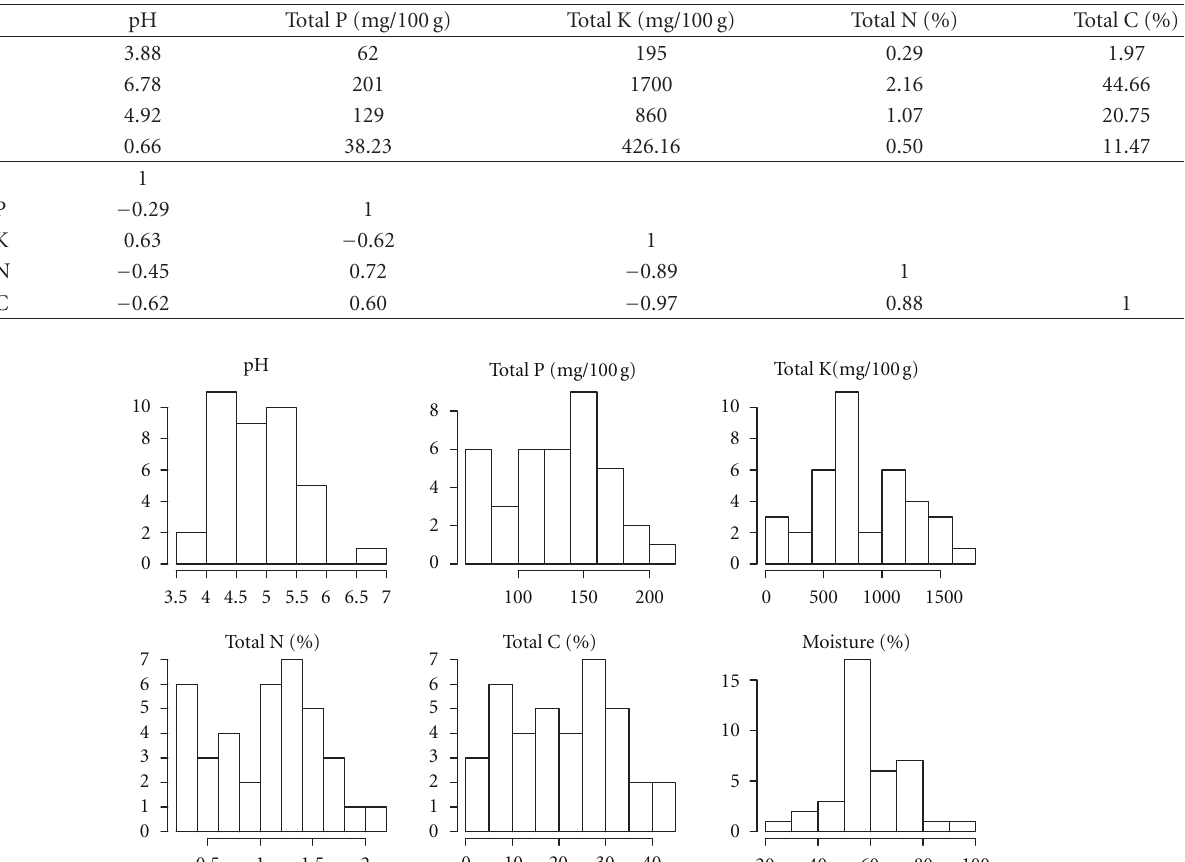
an average C content of 2.56% in Yedoma soils [36], our site shows slightly higher C contents for the sampled depth.